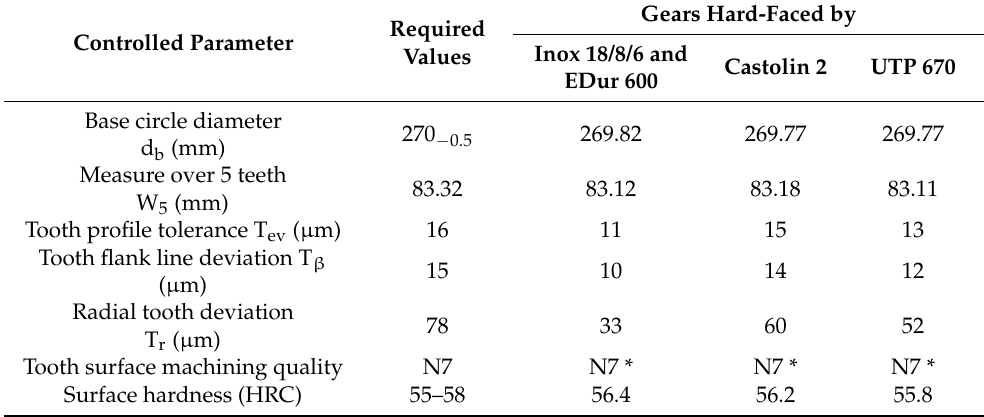
Table 5. Parameters of geometrical and kinematical accuracy of the controlled gears [12].